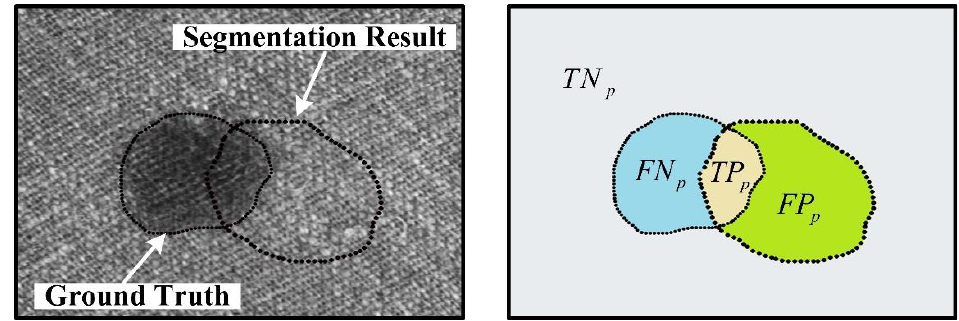
Figure 7. Definition of the FP